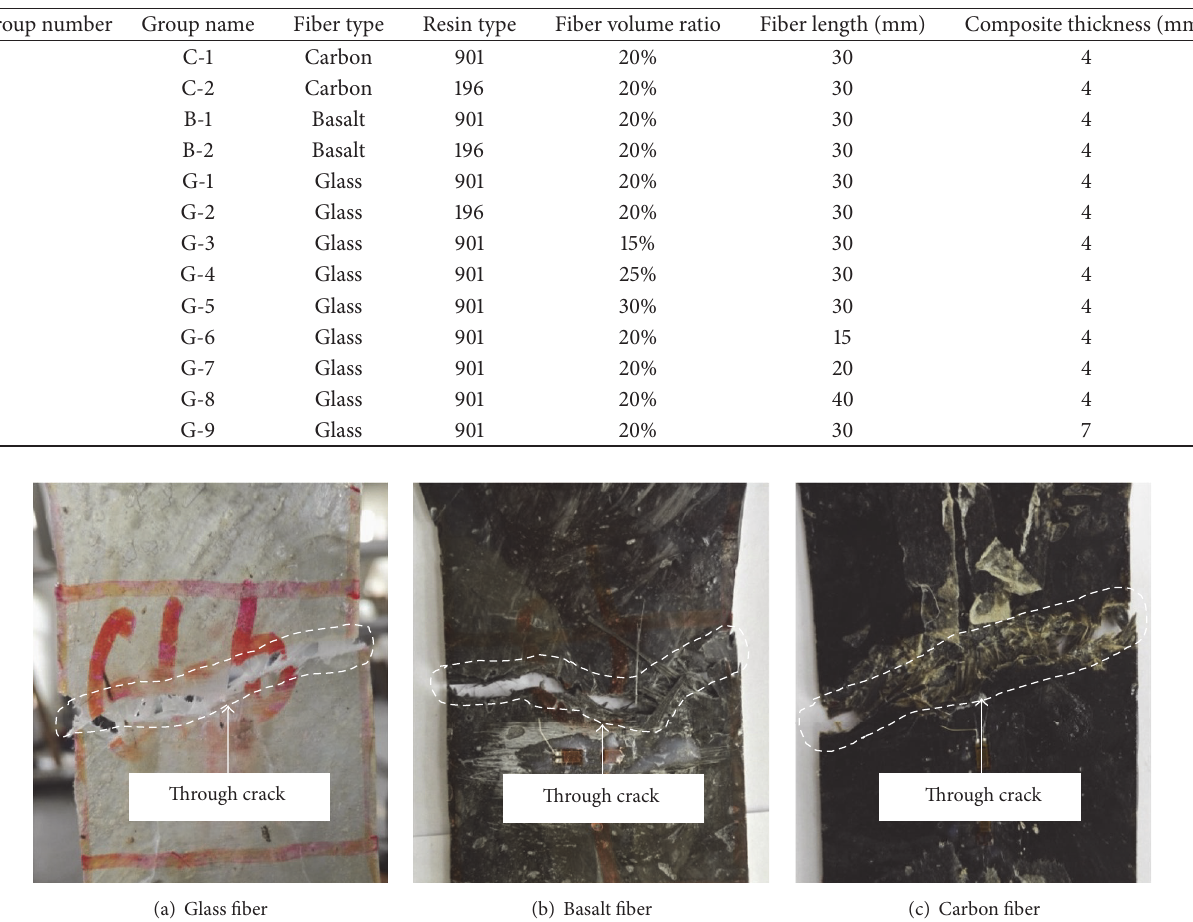
Figure 8: Through cracks in sprayed FRP specimens of different fiber